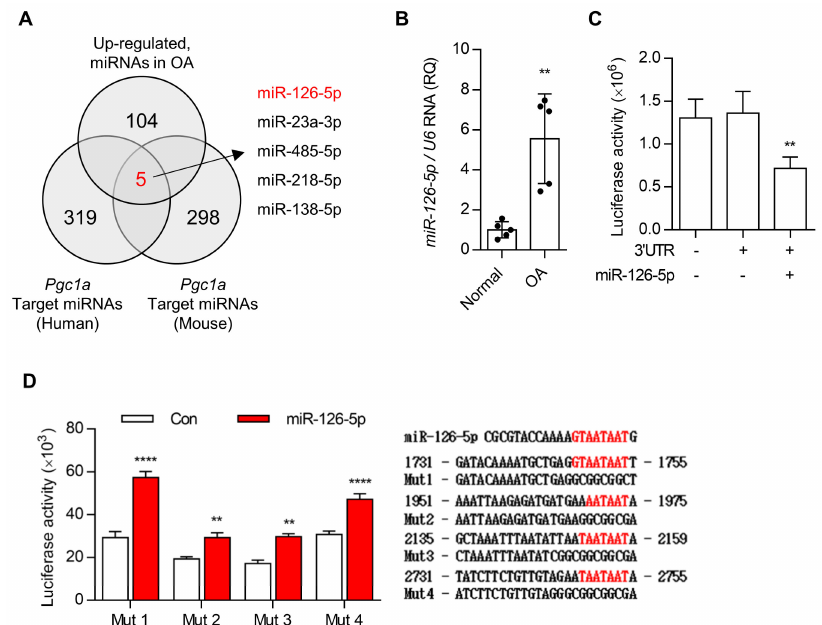
Figure 3. miR-126-5p regulates the expression level of BNIP3 via direct targeting. ( A ) In silico analysis using miRDB and PubMed. ( B ) The expression level of miR-126-5p in normal and OA chondrocytes were analyzed using qRT-PCR ( n = 5). ( C , D ) Luciferase reporter assays of cells expressing the construct containing the Pgc1a -3 (cid:48) UTR or mutated seed sequence of targets in the absence or presence of miR-126-5p ( n = 3). Scramble-miR was used as control (Con). Values were expressed as means ± s.d. An unpaired t -test or one-way ANOVA was used for statistical analysis. ** p < 0.01, **** p <